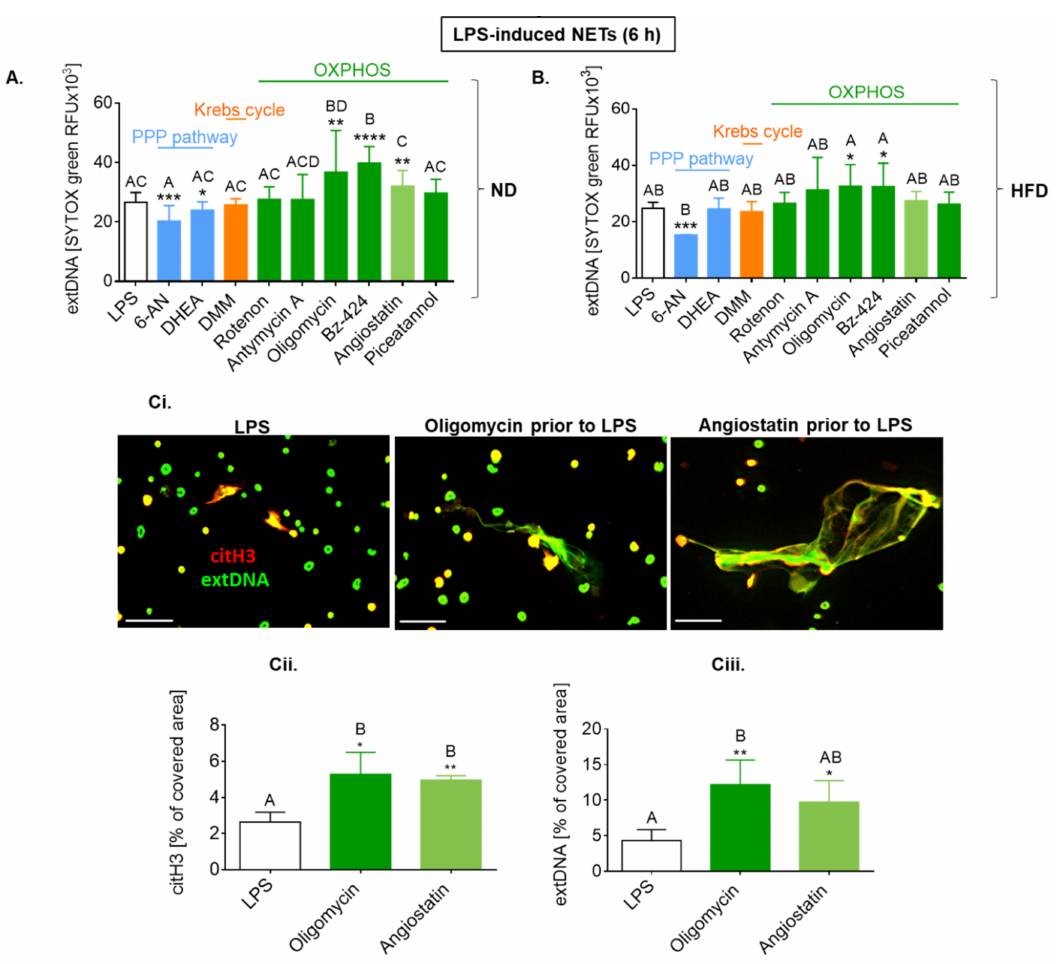
Figure 9. Metabolic pathways involved in long-term LPS-induced formation of neutrophil extracellular traps (NETs) by neutrophils of mice with obesity induced by high fat diet (HFD) and their lean controls (ND). Neutrophils were collected from healthy mice, and prior to ex vivo studies in which they were stimulated with lipopolysaccharide (LPS) for 6 h, they were pretreated with numerous inhibitors. NETs were quantified upon staining of extracellular DNA with SYTOX green and fluorescent signal was measured using a microplate reader in ND ( A ) and HFD ( B ) neutrophil cultures. It is expressed as relative fluorescence units (RFU). Pentose phosphate pathway (PPP) was inhibited with 6-aminonicotinamide (6-AN) and dehydroepiandrosterone (DHEA) (blue columns); Krebs cycle was blocked with dimethyl malonate (DMM, an orange column); OXPHOS was inhibited with a range of inhibitors (rotenone, antimycin A, oligomycin, Bz-423, piceatannol; dark green columns). ATP synthase (mitochondrial and surface) was inhibited with angiostatin (a light green column). ( C ) Effects of oligomycin and angiostatin were recaptured in studies in which NETs were confirmed by immunocytochemical costaining of citrullinated histones H3 (citH3, red) along extracellular DNA (SYTOX green); representative images—( Ci ), and quantification (area [%] covered by neutrophil elastase (NE, ( Cii )) and extracellular DNA (extDNA, ( Ciii ))). Scale bar indicates 50 µ m. Asterisks indicate significant differences between groups upon unpaired two-tailed Student’s t -test (* p ≤ 0.05, ** p ≤ 0.01, *** p ≤ 0.001, **** p ≤ 0.0001). Results of one-way ANOVA (post hoc Bonferroni): any two means that do not share same letter are significantly different. Data are shown as mean ± s.d.; n ≥ 3 per